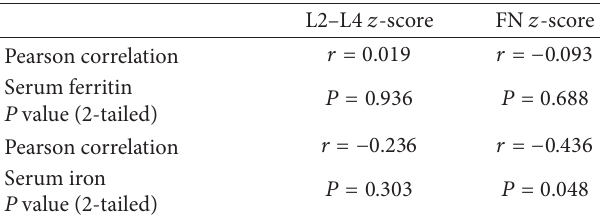
Table 4: Pearson correlations between serum ferritin, serum iron, and 𝑧